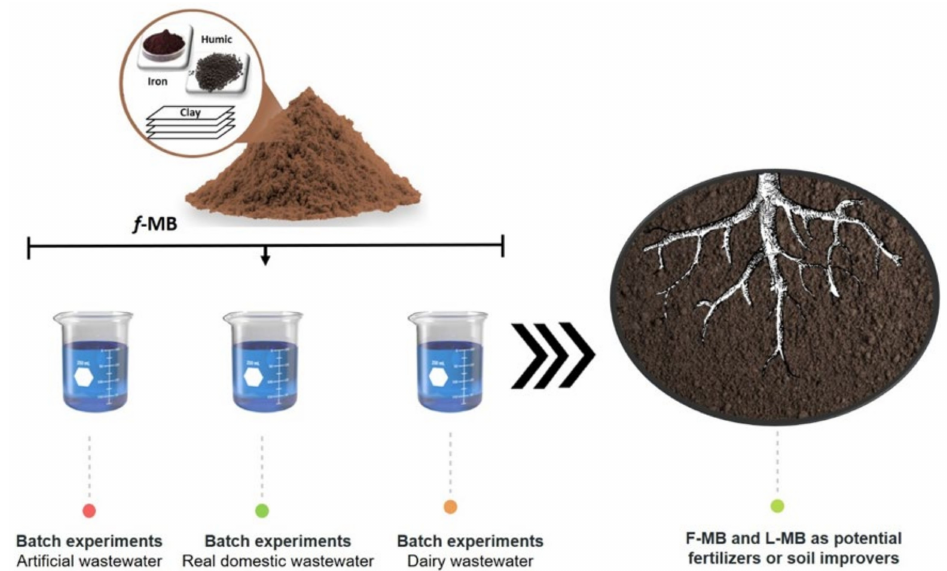
Figure 10. Schematic diagram of the set-up of the batch sorption experiments under different effluents and the application of adsorbents as fertilizers. Source: author’s own